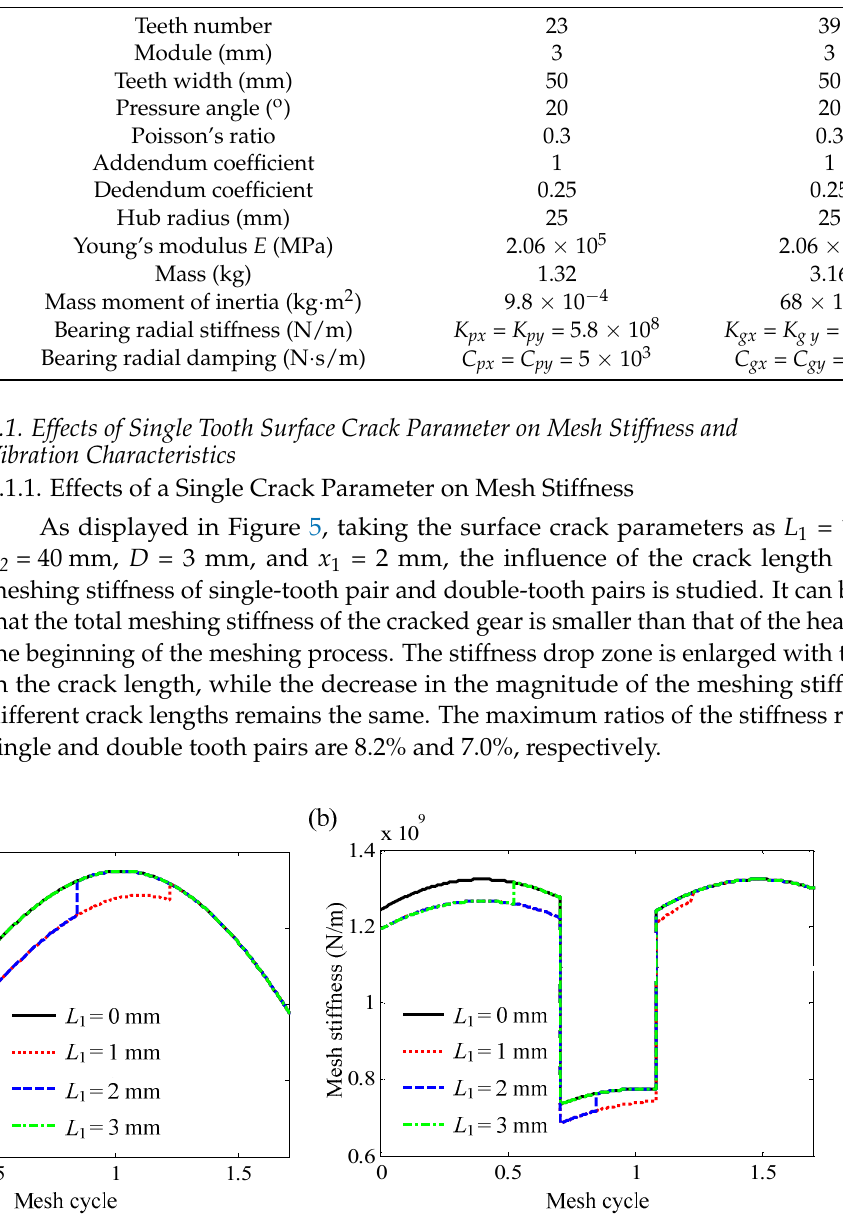
Table 1. Spur gear system parameters.